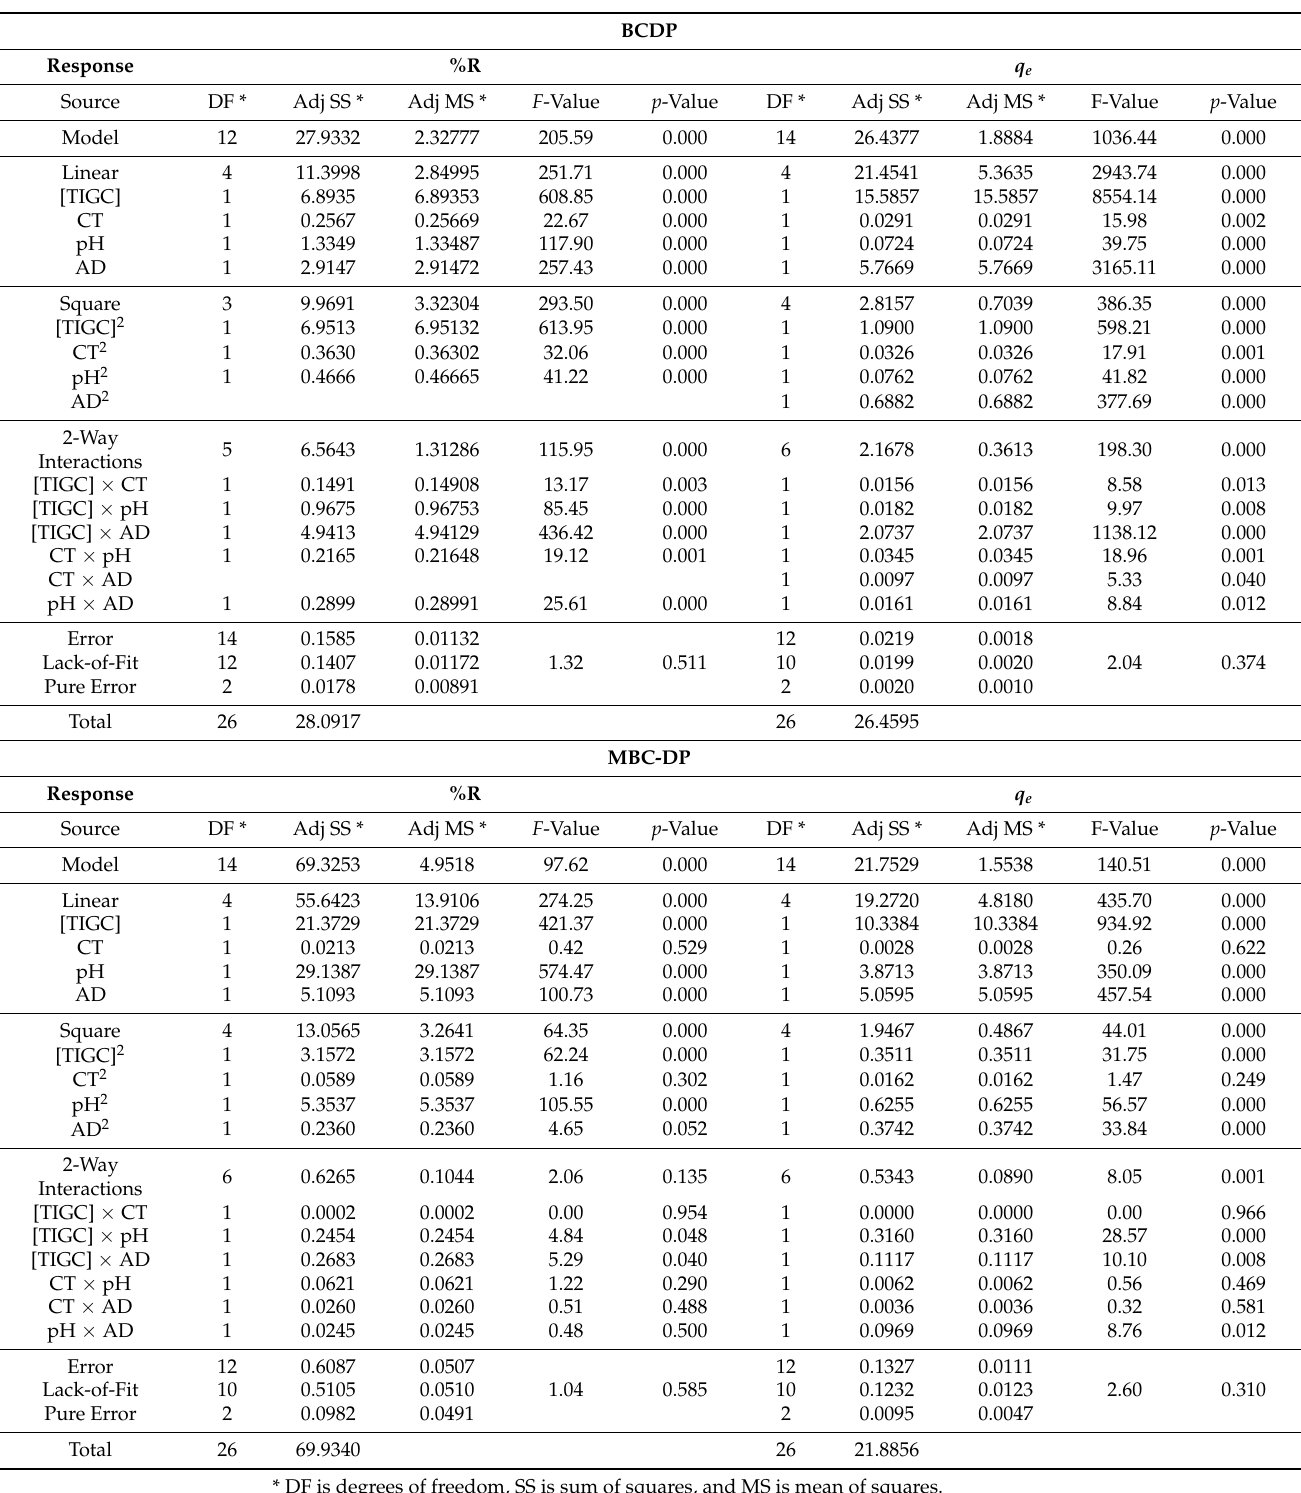
Table 5. Analysis of variance (ANOVA) for the transformed responses for both